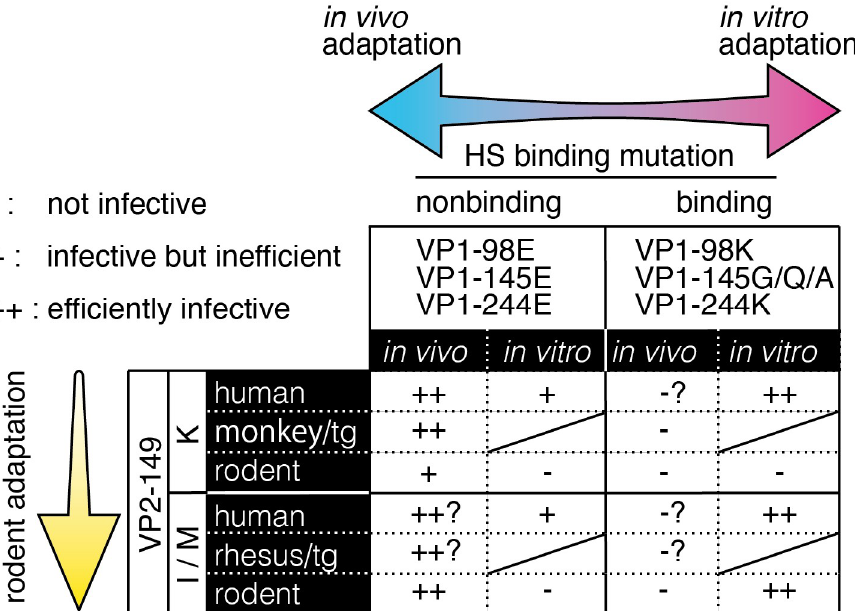
Figure 3. The HS-binding mutation controls in vitro (cultured cells) and in vivo adaptations, whereas the VP2-149 mutation controls adaptation to rodents. Human/in vivo indicates infection of human patients, human/in vitro indicates infection of human-derived cell lines, monkey/tg/in vivo indicates infection of cynomolgus monkeys and hSCARB2-tg mice, rodent/in vivo indicates infection of suckling mice, and rodent/in vitro indicates infection of rodent cell lines.